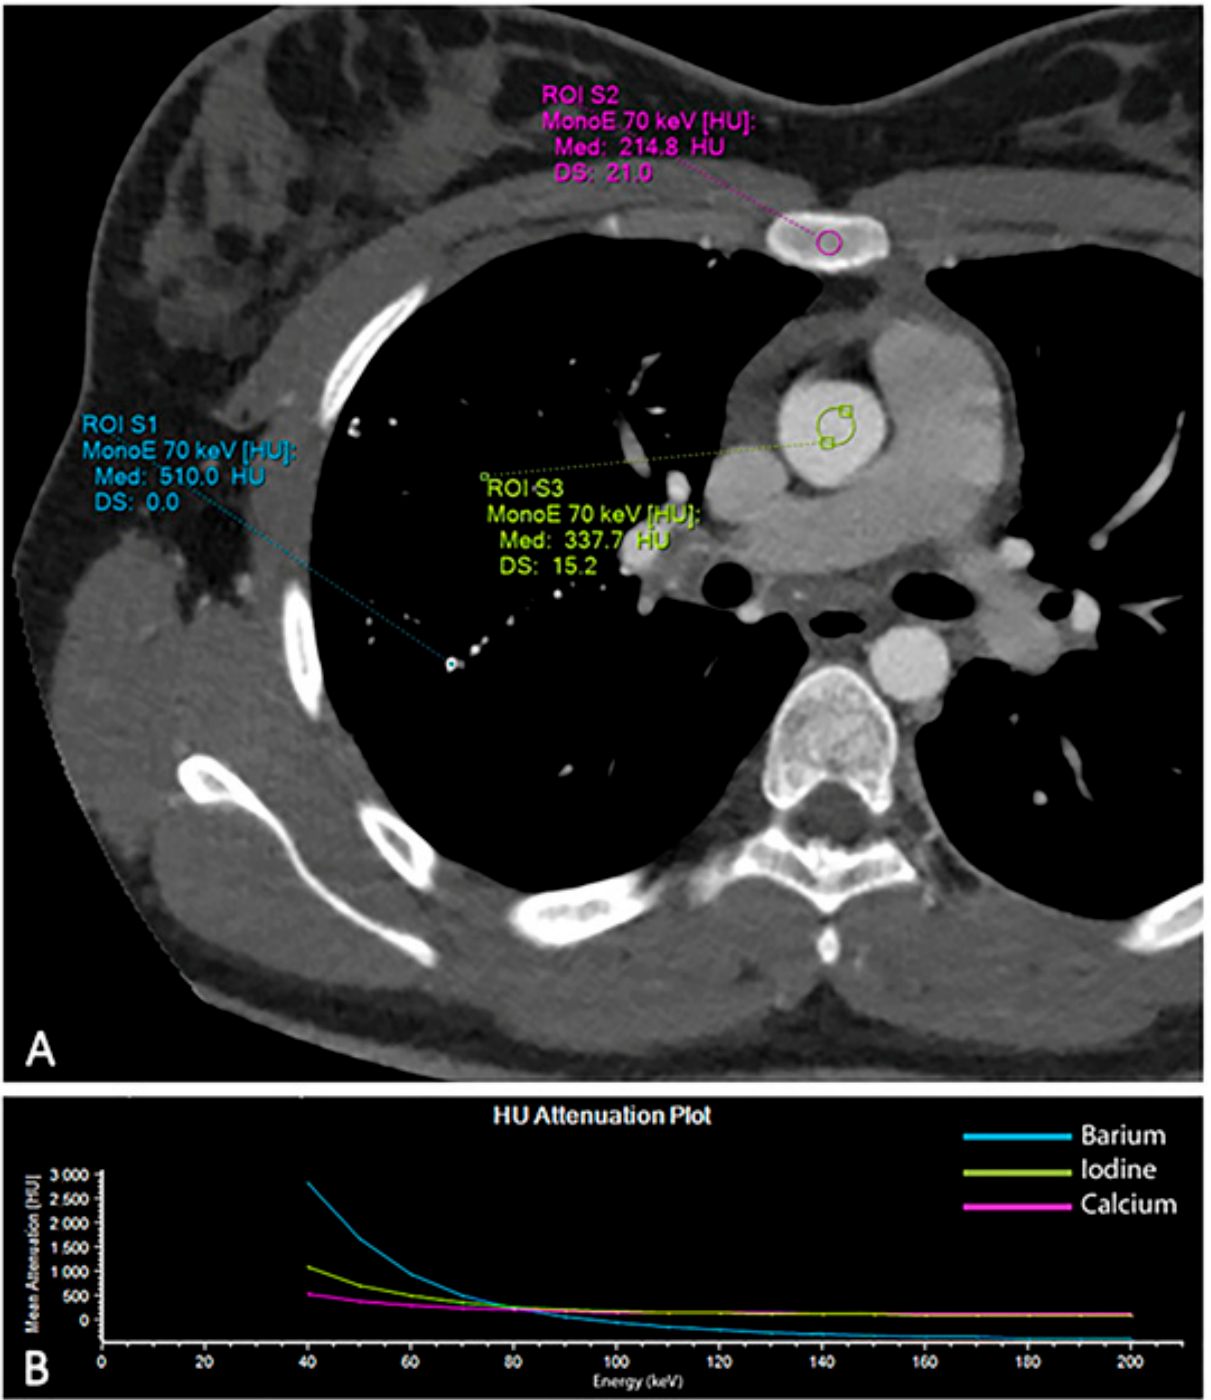
Figure 3. Analysis of the attenuation curves of different materials based on spectral CT data. Regions of interest were placed within the aorta (iodine), in the pulmonary micronodules (barium) and in the sternum (calcium) to investigate the attenuation curves of the different materials ( A ). The graph displays how each material has exclusive changes in attenuation at the different energy levels ( B ).